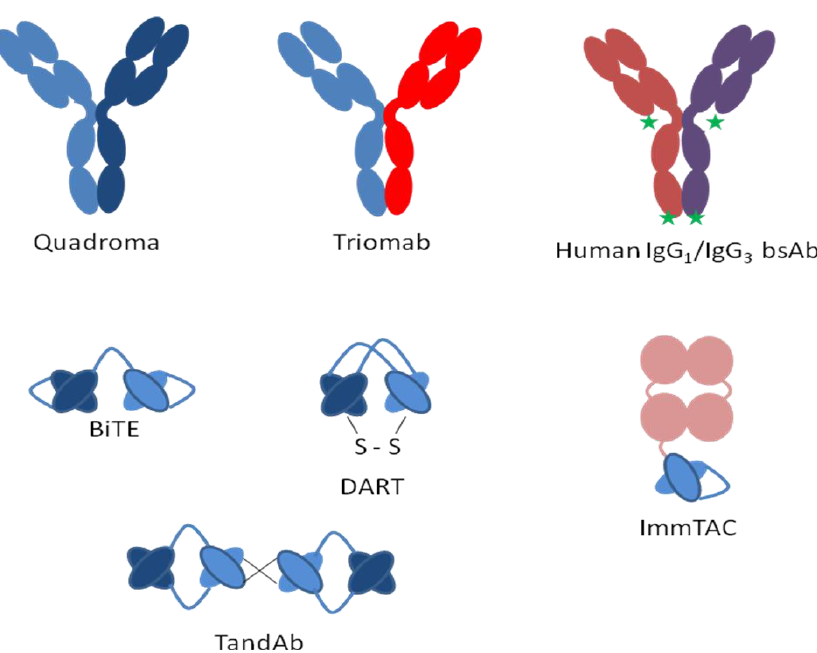
Figure 5. Illustration of various bispecific antibodies, including bispecific T-cell engager (BiTE®), Dual-Affinity Re-Targeting (DART TM ), tetravalent bispecific recombinant antibody (TandAb®), and Immune mobilizing mTCR Against Cancer (ImmTAC). Figure from May et al .